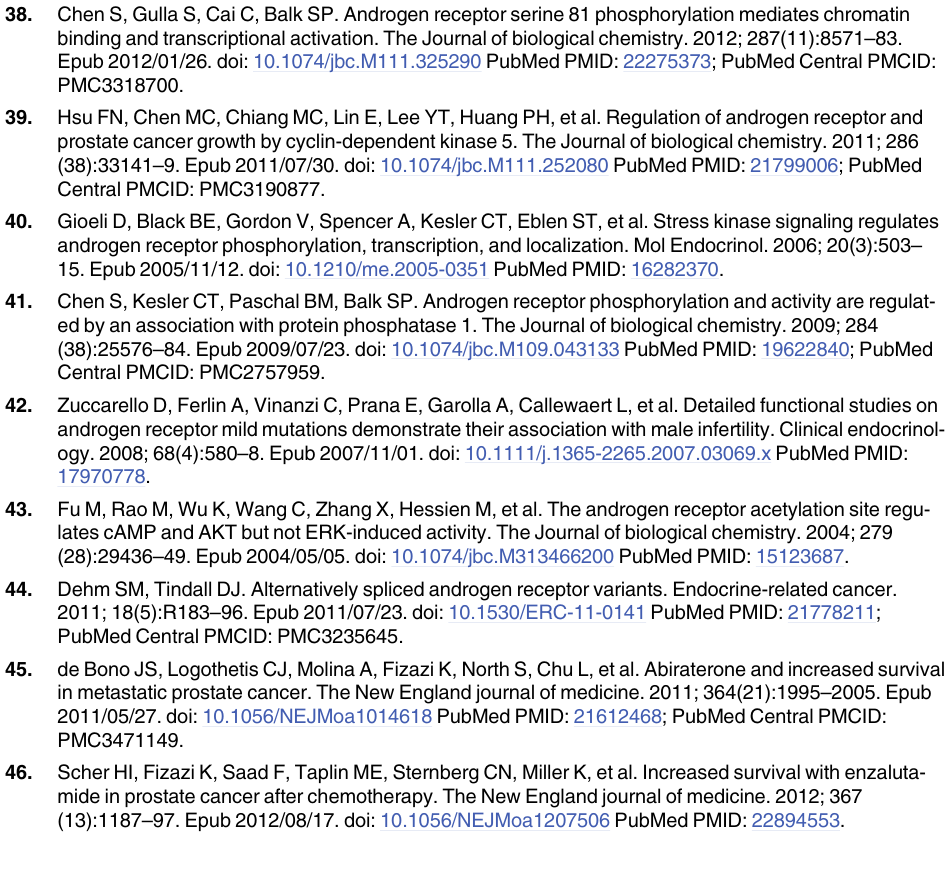
PLOS ONE | DOI:10.1371/journal.pone.0126270 May 7,